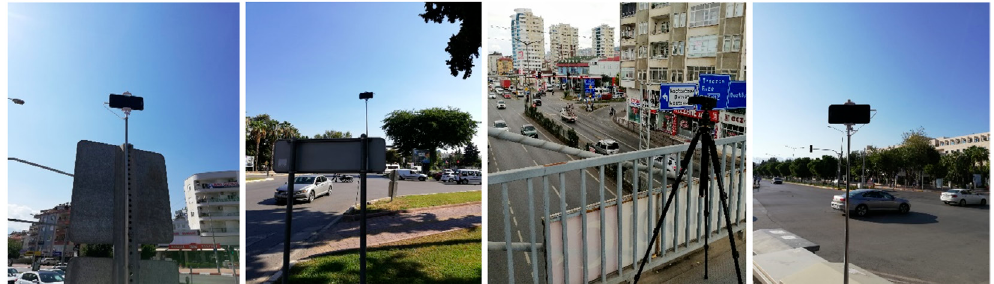
Figure 2. Some sample visuals from data collection process at the examined signalized